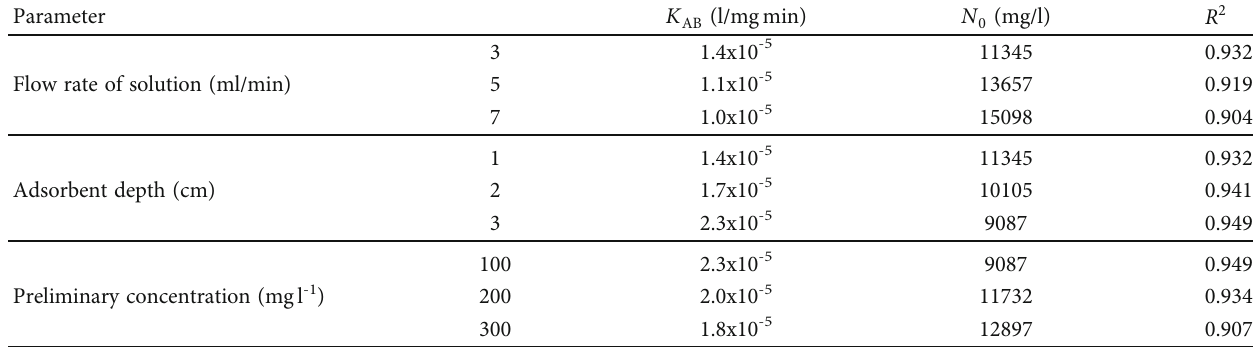
Table 2: Parameters and constants of the Adams-Bohart model for the removal of CV by MGP.